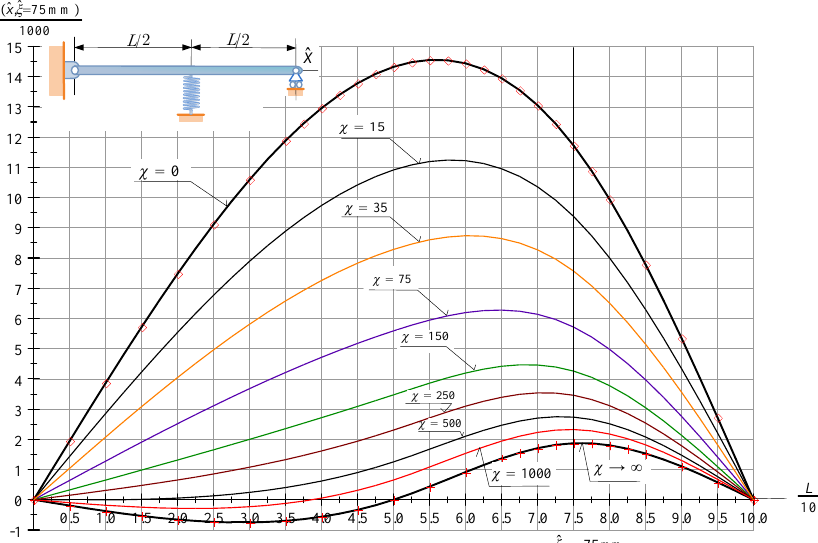
Figure 4. The Green function (the dimensionless vertical displacement field) of a PssP beam subjected to a dimensionless unit force at ξ =